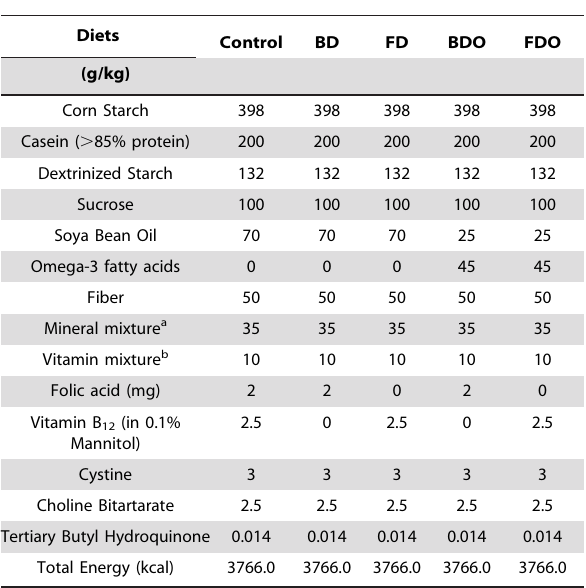
Table 1. Composition of the